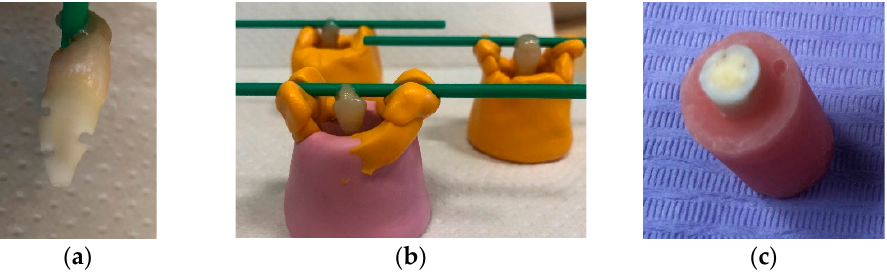
Figure 2. Tooth preparation steps: ( a ) Retention grooves on the root surface; ( b ) Specimens during curing; ( c ) Specimens after preparation.